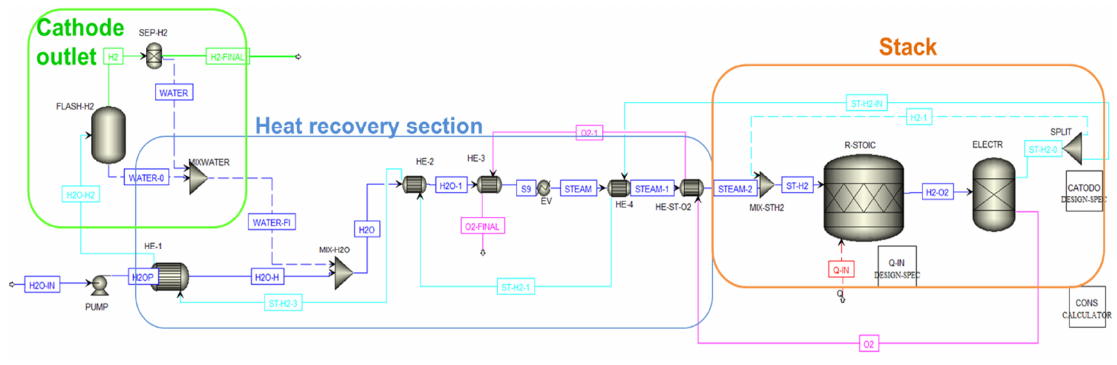
Figure 4. Aspen Plus ® flowsheet of SOEC electrolysis model.